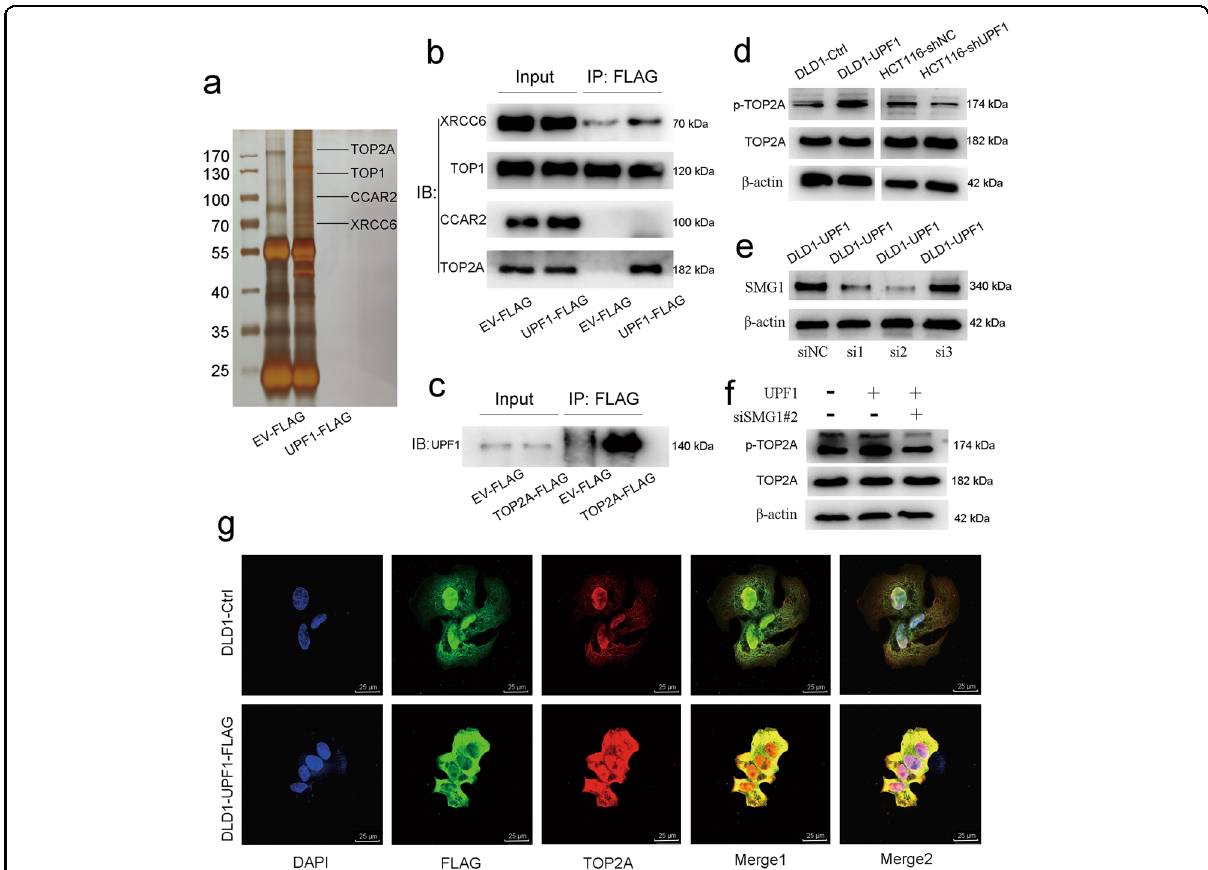
Fig. 4 UPF1 interacted with TOP2A and increased phosphorylated TOP2A. a Signature bands of DLD1-UPF1 cell line emerged after silver staining. The location of TOP2A, TOP1, CCAR2, and XRCC6 were marked. b – c Interaction of UPF1 and TOP2A proved in co-IP assay. ( d ) UPF1 had no in fl uence on the total expression of TOP2A but raised phosphorylated TOP2A at the site of Ser 1106 . e SMG1 was silenced using small hairpin RNAs. f UPF1 raised phosphorylated TOP2A and the elevation was brought to a halt by knockdown of SMG1. g Images of immunocytochemistry assay showed interaction between UPF1 and TOP2A, scale bar, 25 μ